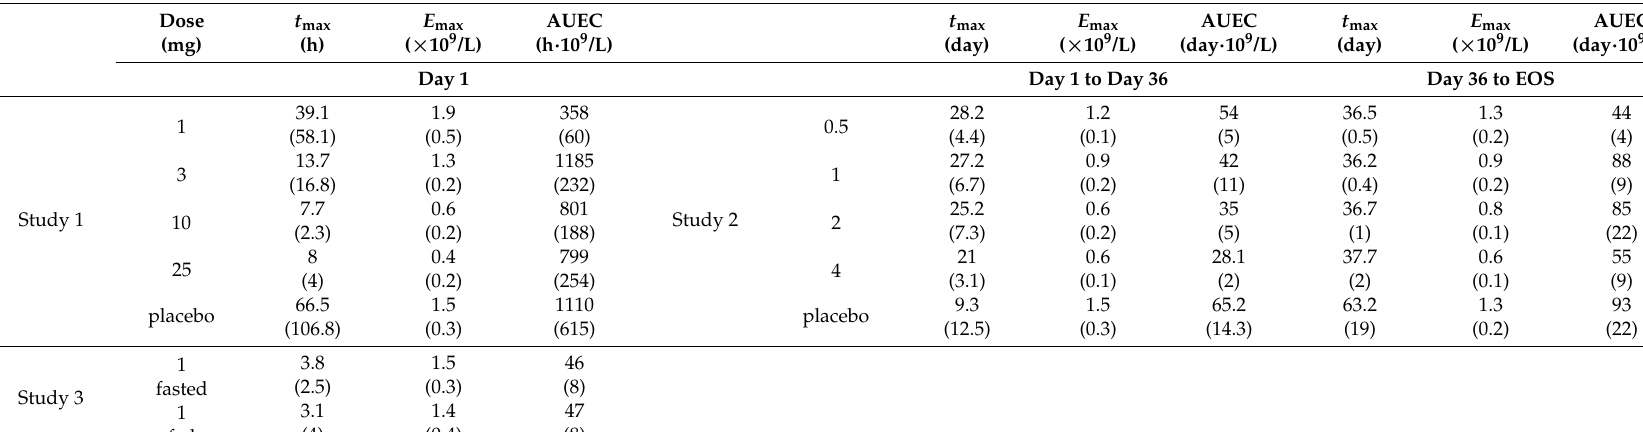
Table 2. Pharmacodynamic variables estimated following single-dose (Study 1), o.d. for 35 days (Study 2), and single-dose administration in fed or fasted conditions (Study